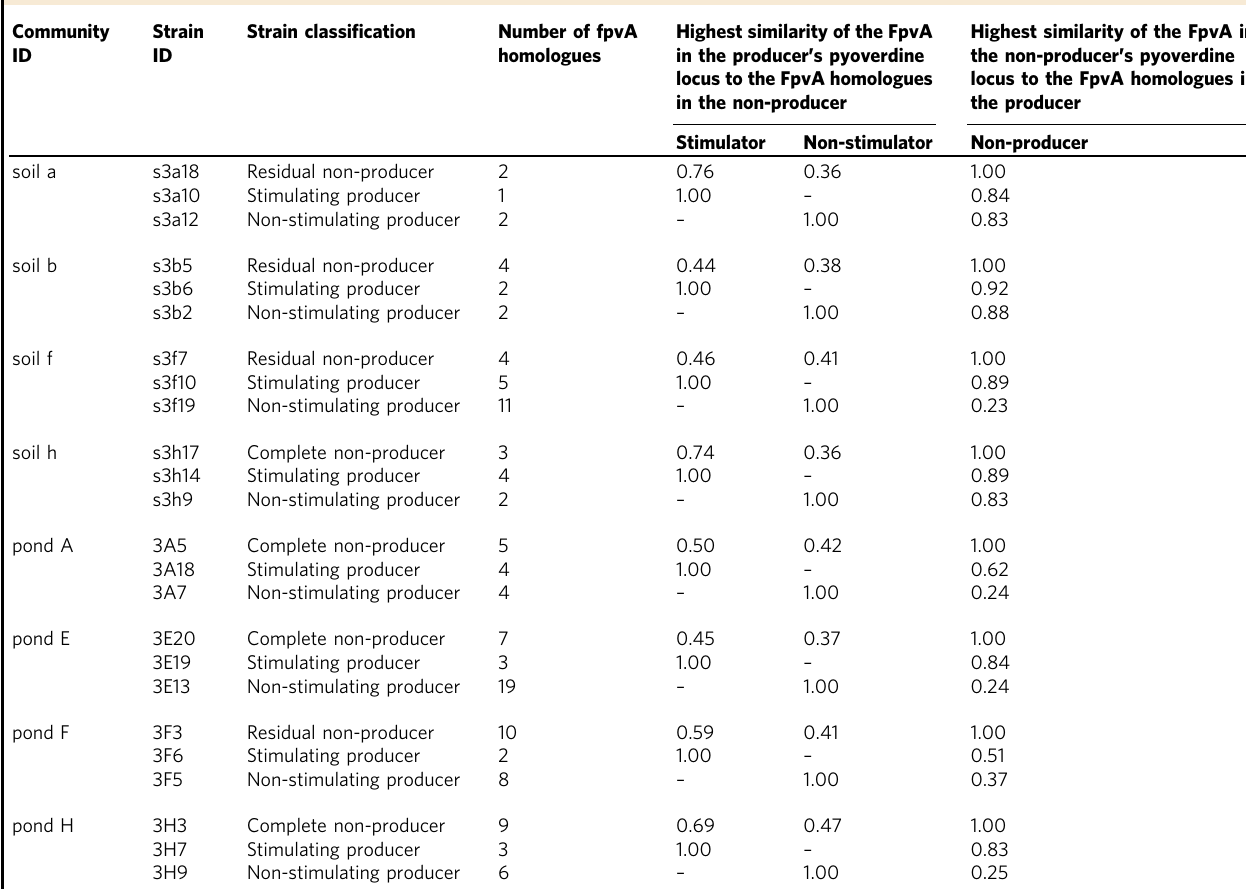
Table 2 Numbers and similarities of the FpvA pyoverdine receptors between producers and non-producers Community Strain Strain classi fi cation Number of fpvA ID ID